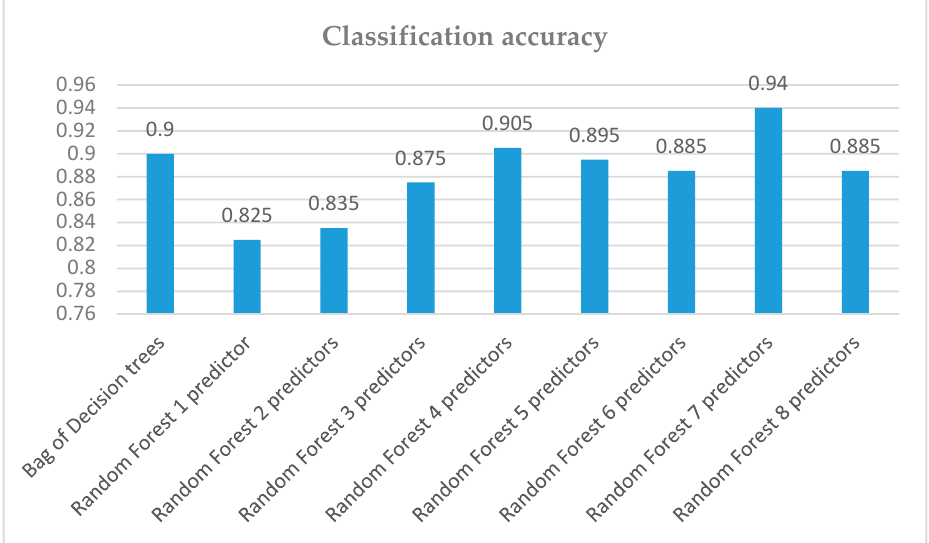
Figure 8. Behavior of Random Forest classifier with different number of features.